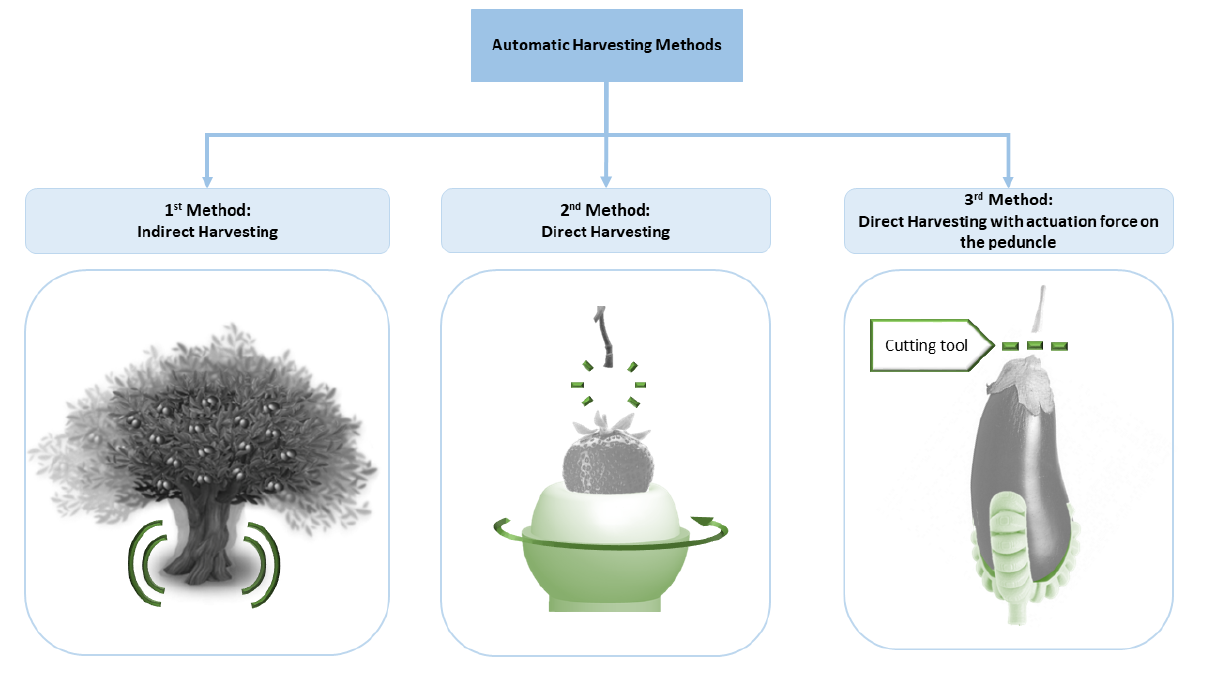
Figure 1. Classification of automatic harvesting